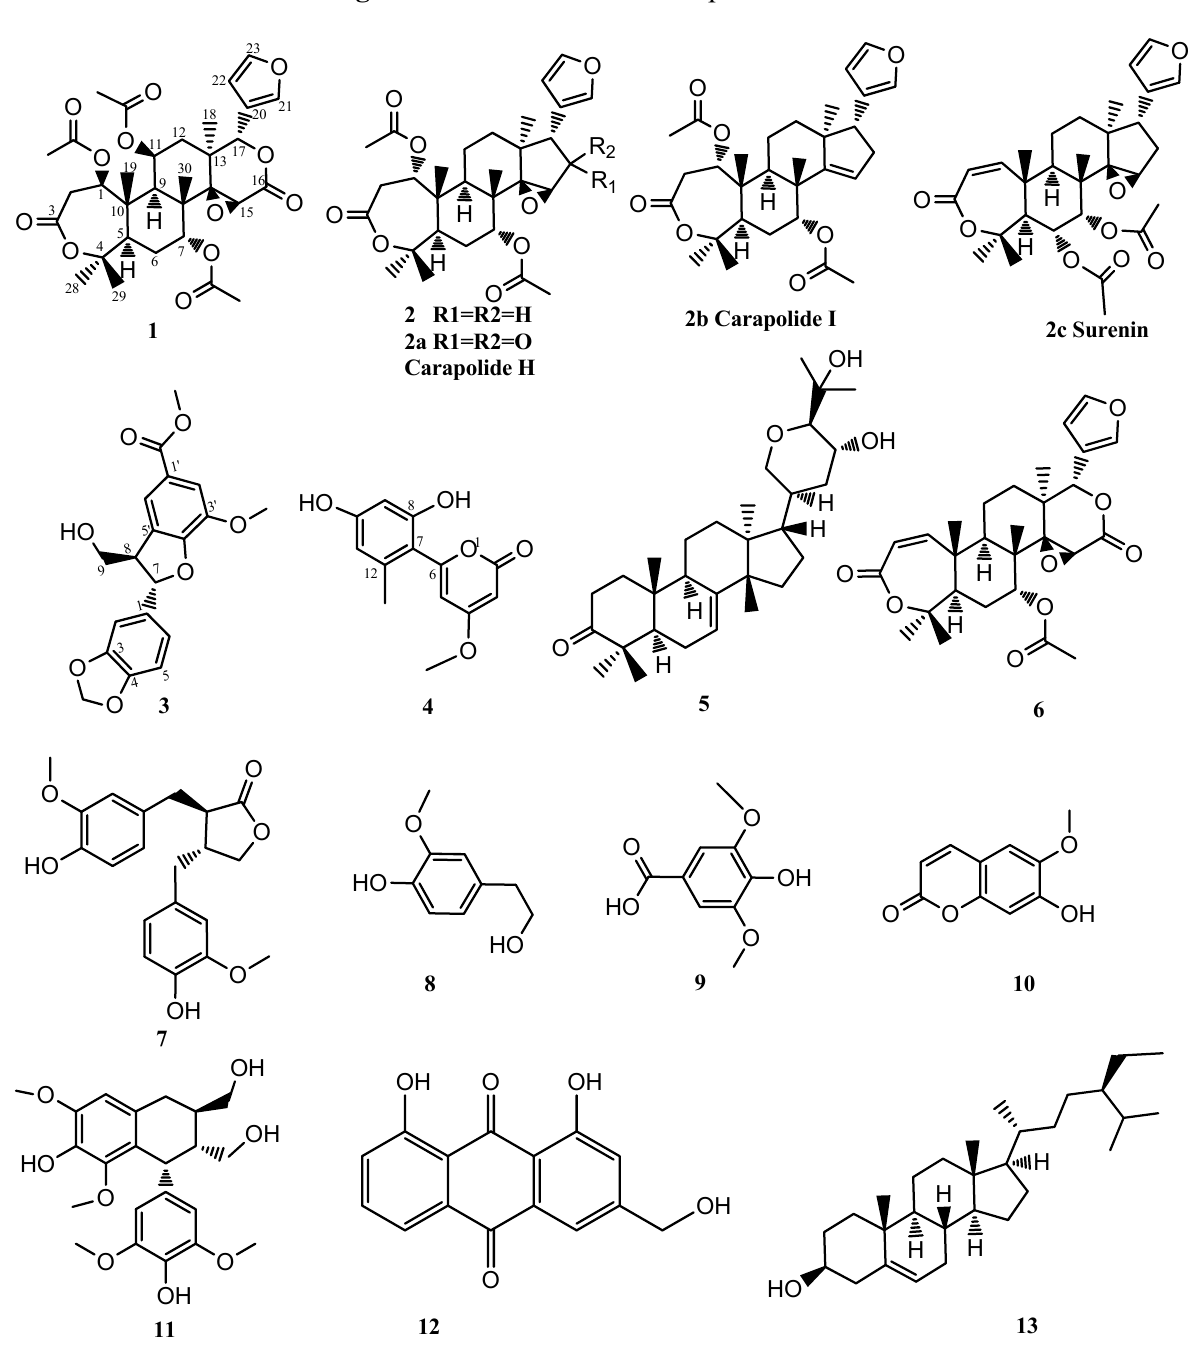
Figure 2. Structures of the compounds 1 – 13